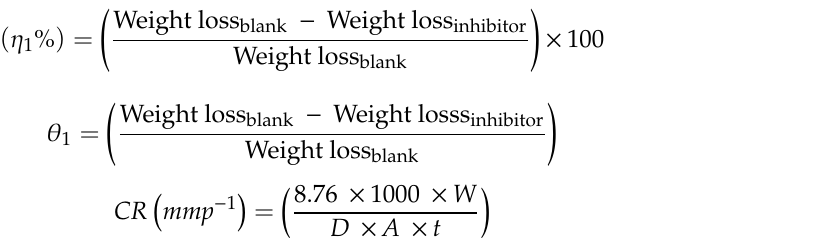
Table 2. Different corrosion parameters: corrosion rate ( CR ), surface coverage ( θ 1 ), and inhibition